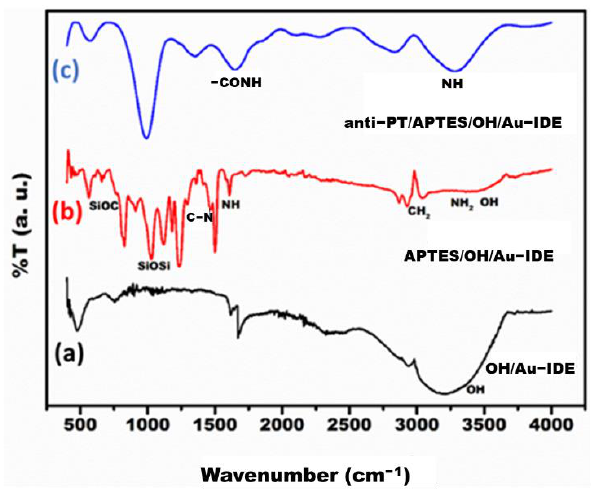
Figure 3. FTIR spectra at different stages of modification: ( a ) OH modified IDE, ( b ) after APTES modification and ( c ) after anti−parathion immobilization.